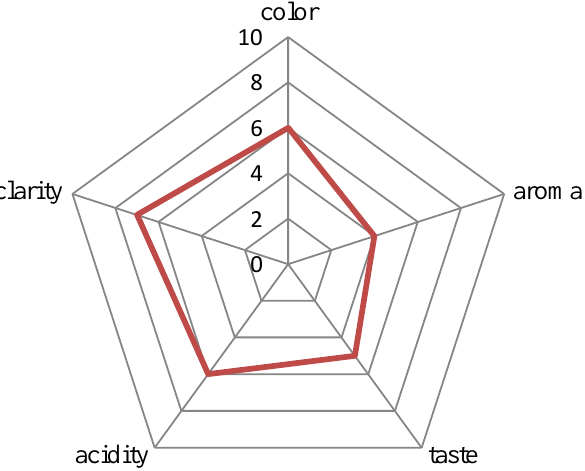
Figure 2. The influence of ozonation process on yeasts survival in wine. There are three separate experiments (wines), marked by letters A–C. Means and 95% standard deviations are marked in Figure.